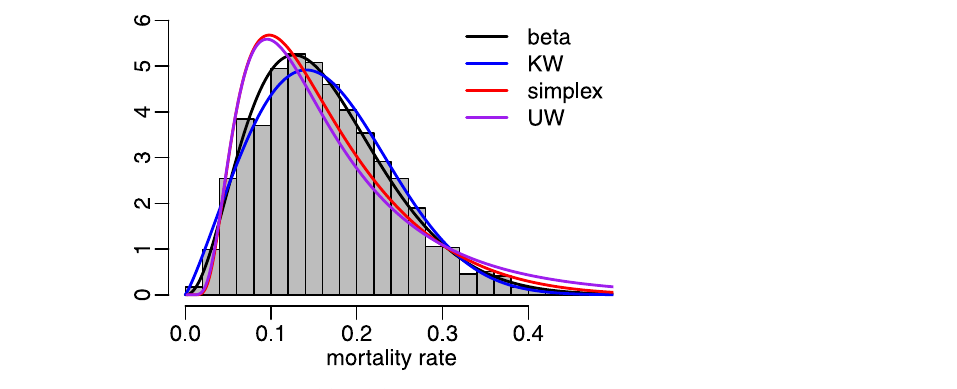
runner-up according to AD, behind the Kumaraswamy model]. Considering the eight mea- sures and the three sample periods, the beta law was the winner in 21 out of the 24 cases. Fig 11 contains the data histogram and the estimated beta density for period 3, as in Fig 8, together with the fitted Kumaraswamy (KW), simplex and unit Weibull (UW) densities. Visual inspection of the figure shows that the beta law best fits the data histogram. In order to further examine the two best data fits, we produced quantile-quantile (QQ) plots for the beta and